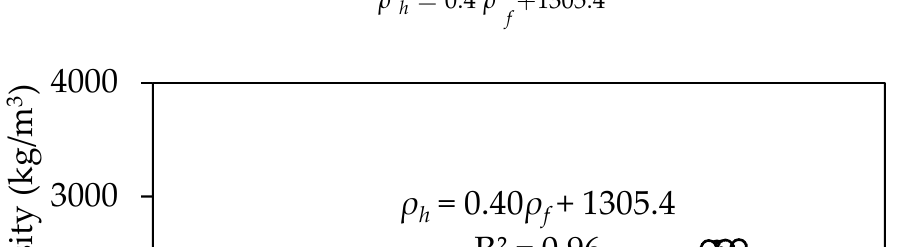
( ρ h ) from the measured fresh concrete density ( ρ f ) for slag-fly ash blended geopolymer concrete presented in this work.